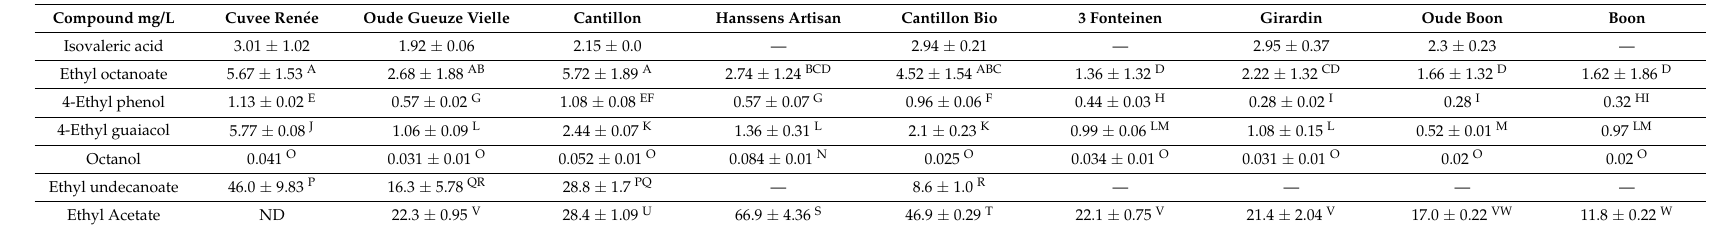
Table 5. Quantification of Compounds for Commercial Lambic